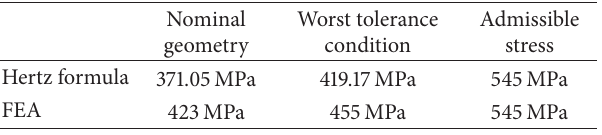
Table 3: Analytical and numerical contact pressure in separation system interface.